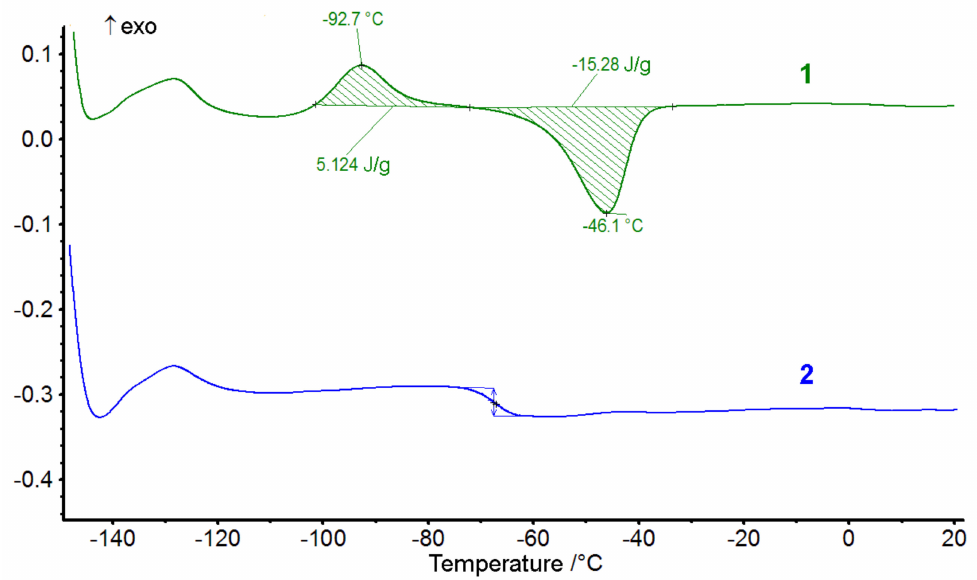
Figure 8. DSC curves of block-copolymers L-PDMSIV and